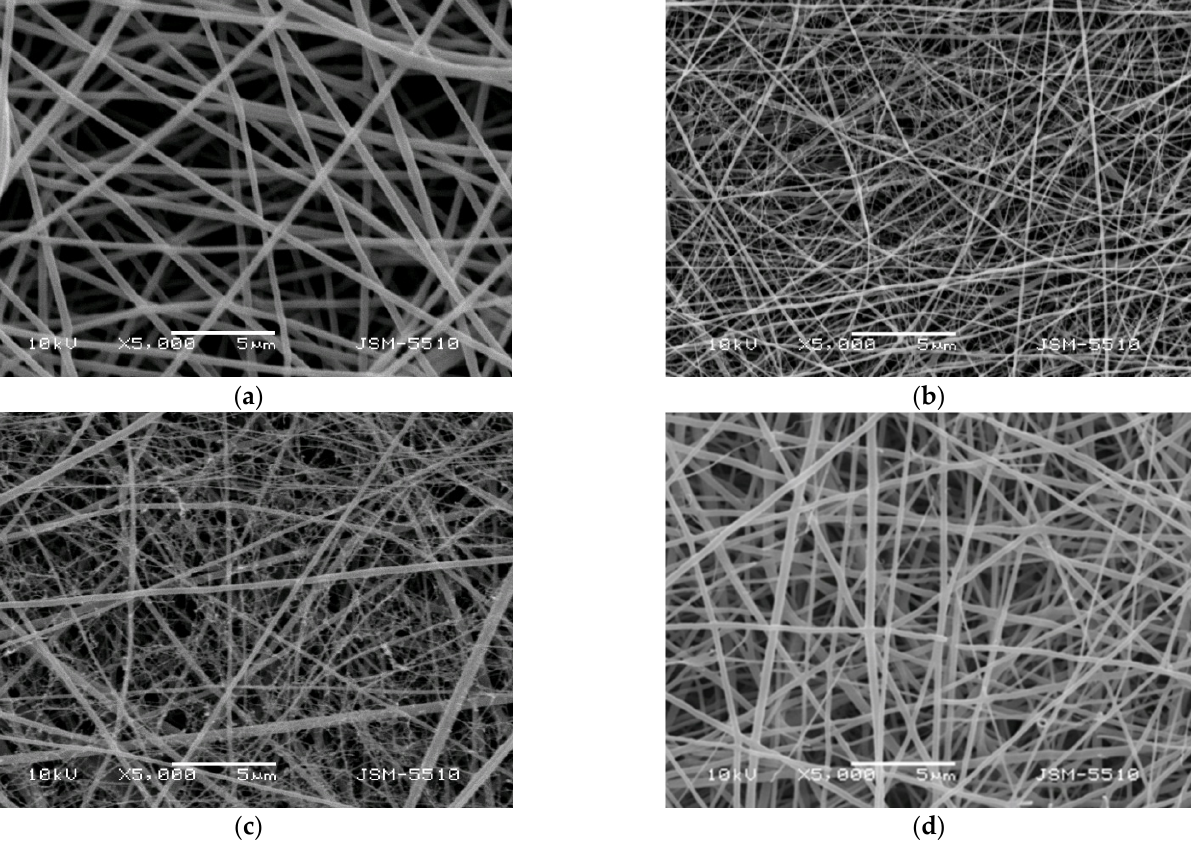
Figure 1. SEM micrographs of electrospun mats of ( a ) PLA, ( b ) Ch-8Q/PLA (50:50 w / w ), ( c ) Ch-8Q/PLA (30:70 w / w ) and ( d ) Ch/PLA (30:70 w / w ); magnification ×5000. For the Ch-8Q/PLA system at a weight ratio of Ch-8Q:PLA = 30:70, the average fiber diameter was 187 ± 128 nm, while at a weight ratio of Ch-8Q:PLA = 50:50, it was 124 ± 45 nm (Figure 1b,c). The average diameter of Ch/PLA fibers (weight ratio Ch:PLA = 30:70) was 238 ± 105 nm. The dynamic viscosities of the solutions of PLA, Ch/PLA (Ch:PLA = 30:70 w / w ), Ch-8Q/PLA (Ch-8Q:PLA = 30:70 w / w ) and Ch-8Q/PLA (Ch-8Q:PLA = 50:50